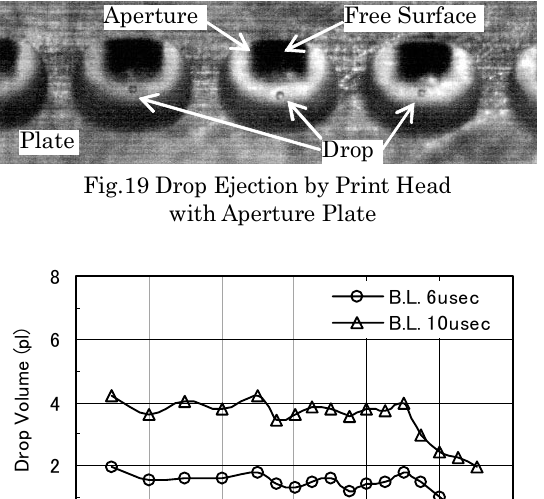
Aperture Drop Fig.18 Cross Section around Aperture Plate